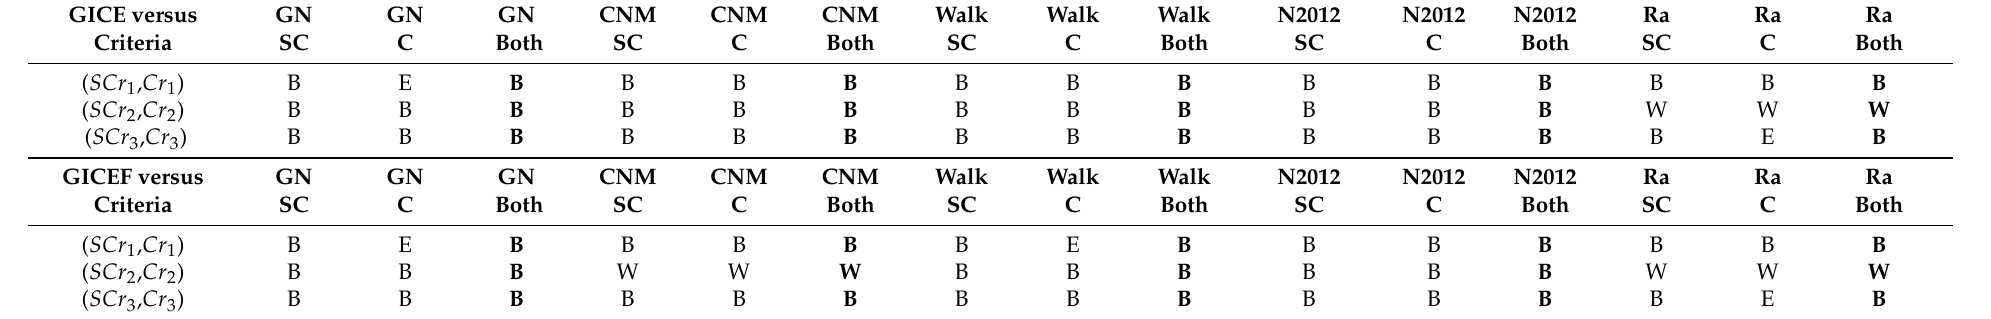
Table 8. Comparison between GICE and GICEF algorithms versus GN, CNM, Walktrap (Walk), N2012 and Radicchi (Ra) algorithms from a Modularity and Homogeneity point of view in the criteria Cr 1 , Cr 2 , Cr 3 and SCr 1 , SCr 2 , SCr 3 for Les Miserables network. Letter B represent that our algorithm present better performance in this criteria, W worst and E represent that the difference is not significative.